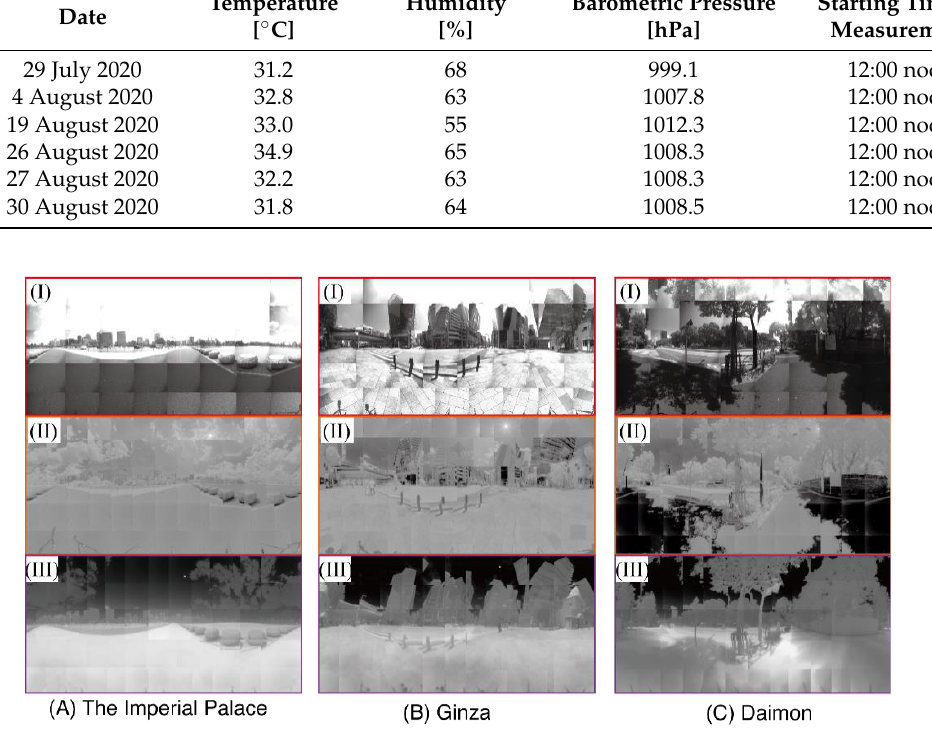
Figure 8. Measured images in summer experiments at ( A ) the Imperial Palace, ( B ) Ginza, and ( C ) Daimon with ( I ) visible, ( II ) near-infrared, and ( III ) infrared camera in summer.